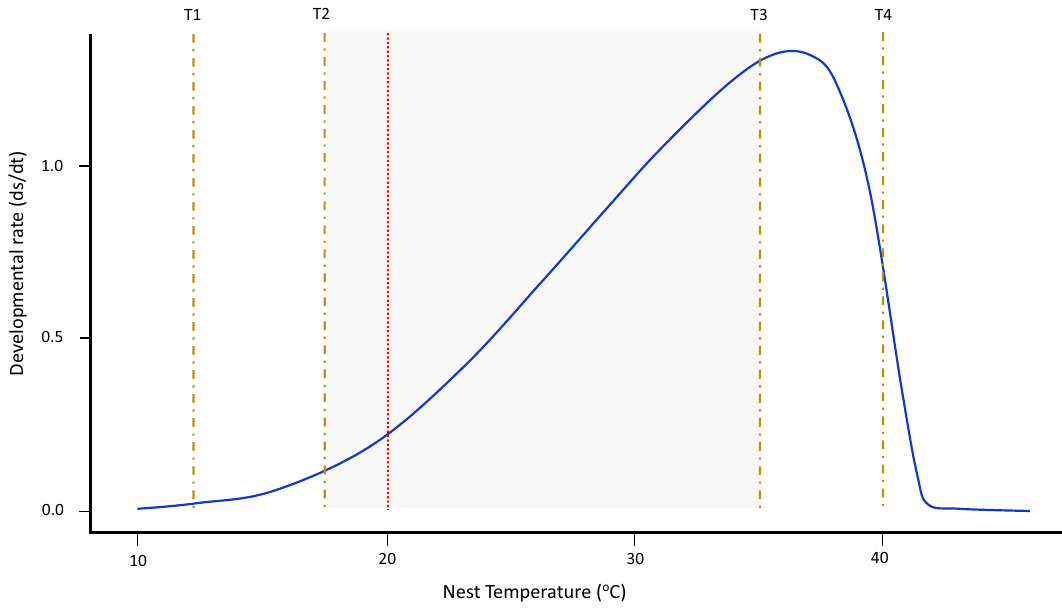
Figure 2. The Dallwitz-Higgins model 35 applied to Bassiana duperreyi nest data. T1 and T4 are the lower and upper absolute lethal limits, outside which even brief exposure causes embryo death. T2 and T3 are the constant-temperature lethal limits, outside which a temperature held constant throughout incubation will cause embryo death or gross abnormality. Temperatures in the sublethal ranges T1 –T2 and T3 –T4 will support embryonic development (Optimal Thermal Range indicating the shaded area), provided exposure is for a part of each day only, but the duration of vulnerability that can be tolerated will decline as one move to extremes. Red broken line denotes the sex reversal threshold for B. duperreyi according to Shine et al. 15